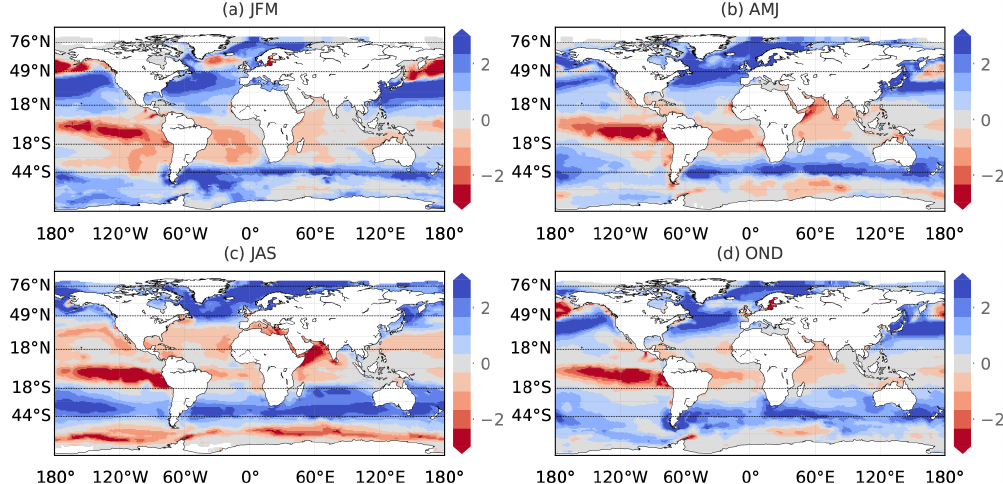
Figure 8. Seasonality of downward CO 2 fluxes (molCm − 2 yr − 1 ) in 1985–2019. Temporal means of the reconstructed fg CO 2 field for January to March (JFM), April to June (AMJ), July to September (JAS), and October to December (OND) are